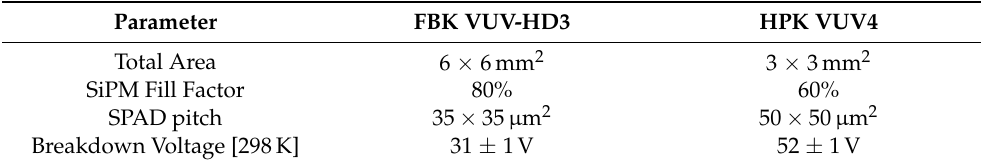
Table 1. Summary of the SiPM specification whose secondary photon emission is studied in this work [2,6]. The Fill Factor is defined as the ratio between the photon-sensitive area to the total area of the SiPM. The breakdown voltages are extracted from the SiPM I-V curves; defined as the voltage for which the first derivative with respect to the voltage of the SiPM current (in log space) is at the maximum [23]. Parameter FBK VUV-HD3 HPK VUV4 Total Area 6 × 6mm 2 3 × 3mm 2 SiPM Fill Factor 80% 60% SPAD pitch 35 × 35 µ m 2 50 × 50 µ m 2 Breakdown Voltage [298K] 31 ± 1V 52 ± 1V